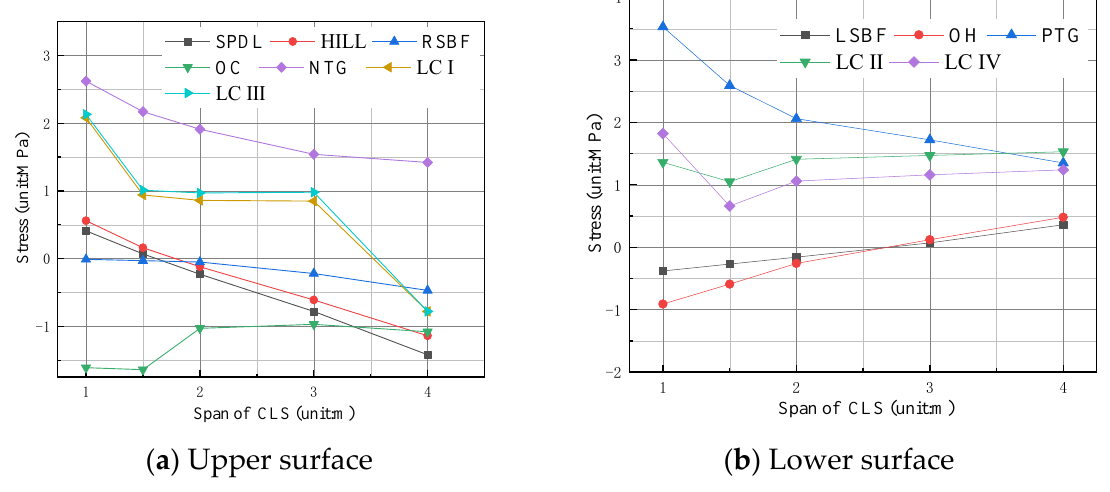
Figure 16. Curve of the maximum principal tensile stress vs. CLS span.